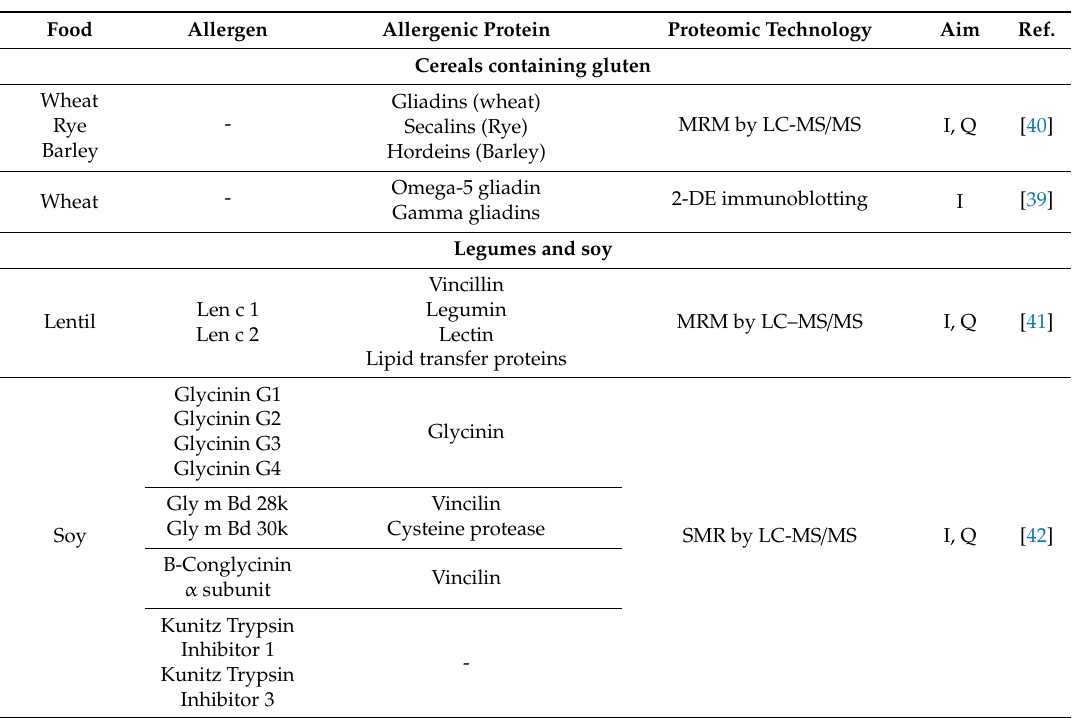
Table 1. A non-exhaustive list of current proteomics technologies for food allergen detection and quantification in plant-based